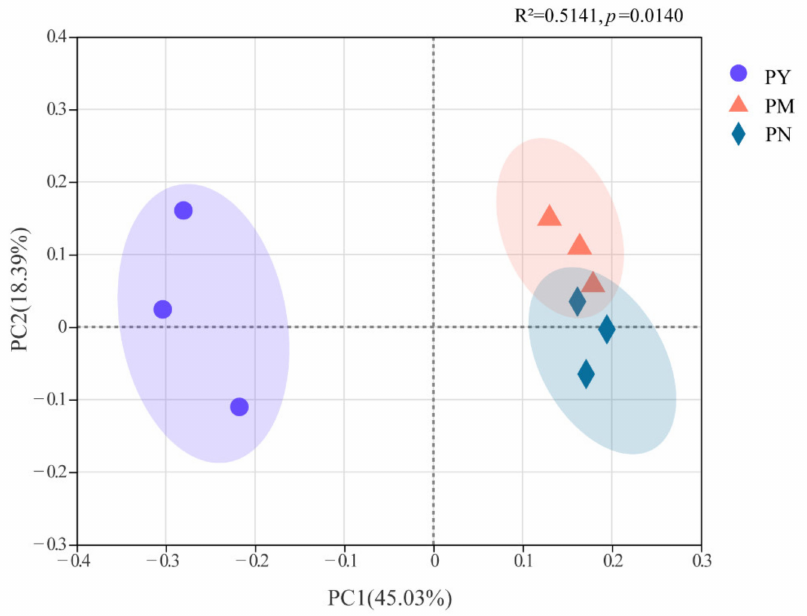
Figure 6. Principal coordinates analysis of the composition of rhizosphere soil fungal community of P. tabuliformis at different stand ages. The level of fit and the significance of the relationships are shown in the top right corner of the panels. PY: young forest (10a), PM: middle-aged forest (20a), and PN: near-mature forest